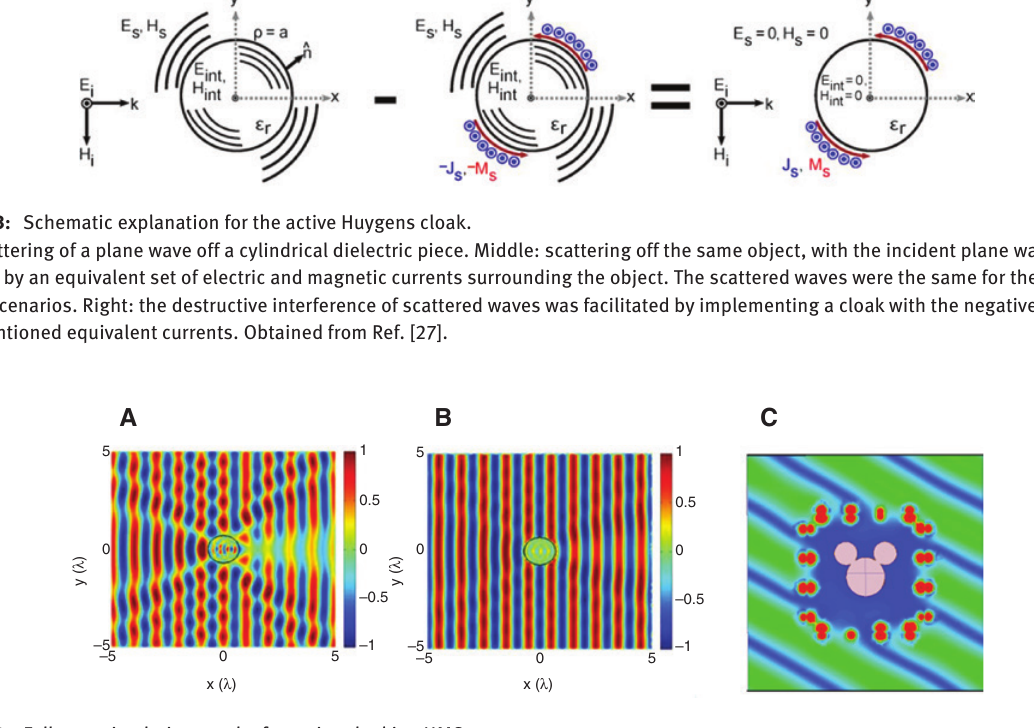
Figure 24: Fullwave simulation results for active cloaking HMS. (A) Total electric field (real part) of a scattering experiment involving the dielectric cylinder. Obtained from [27]. (B) Same simulation as (A) but with the cloak turned on. Obtained from [27]. (C) Scattering cancellation for a square-shaped cloak concealing an arbitrary object placed inside the